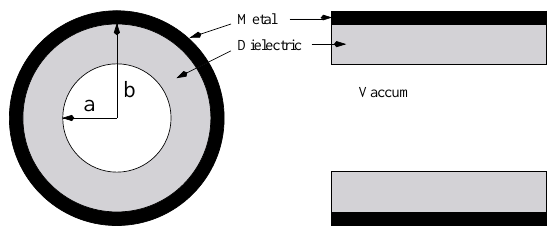
FIG. 1. Dielectric waveguide